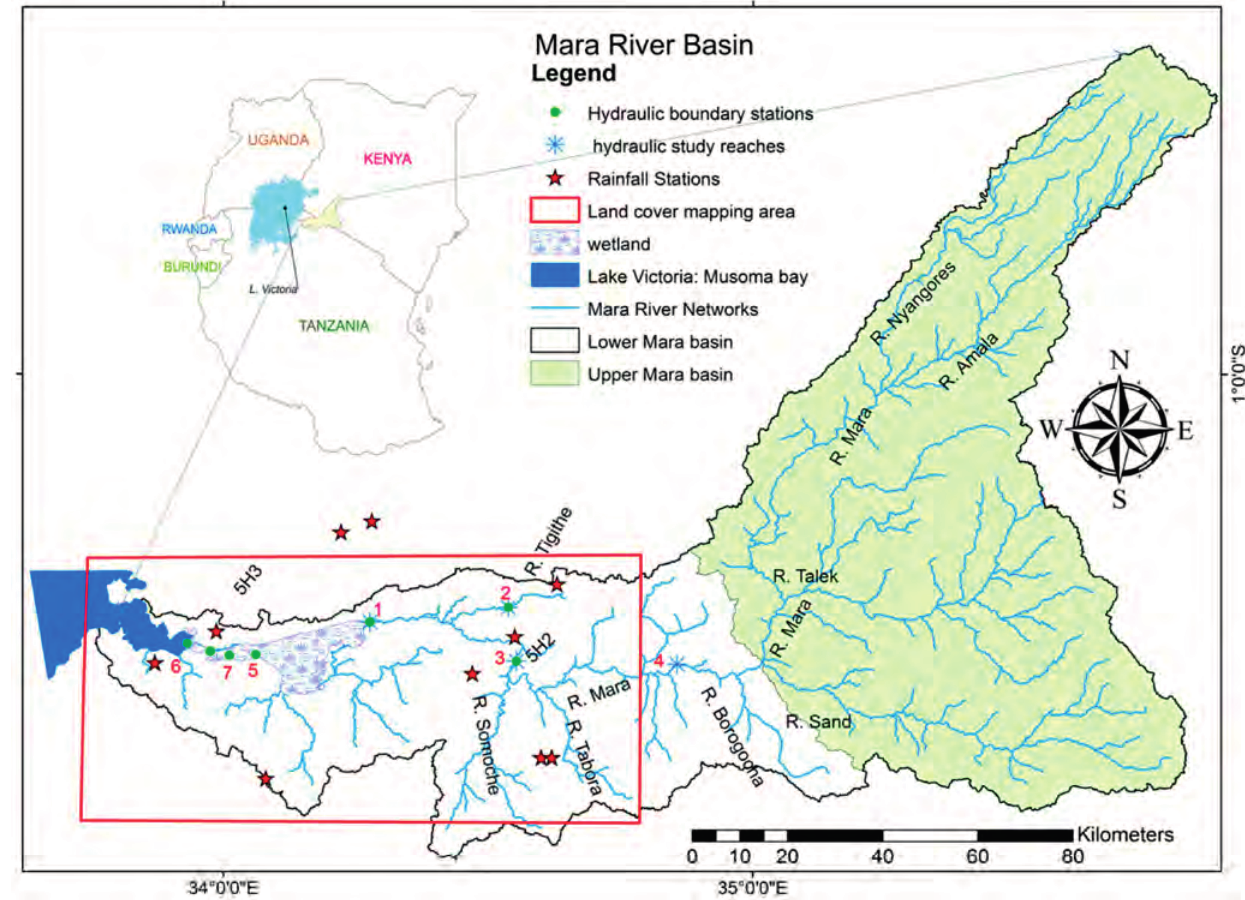
Figure 1. Location of the study area (rectangle) within the lower Mara River